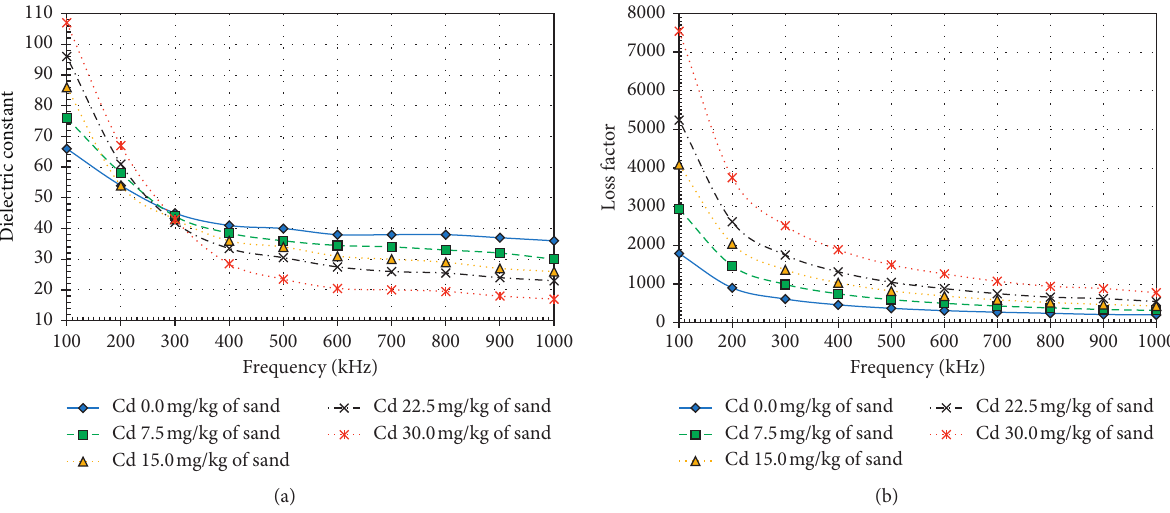
Figure 4: Complex permittivity of sand contaminated with Cd. (a) Dielectric constant versus frequency. (b) Loss factor versus